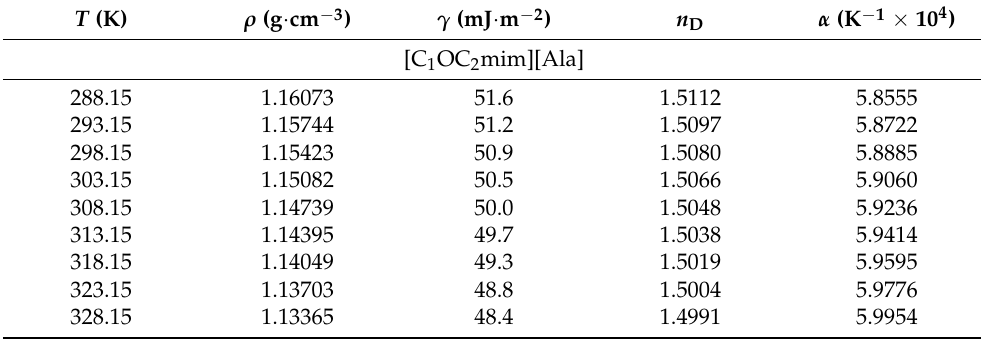
Figure 1. Density ( ρ ), surface tension ( γ ), and refractive index ( n D ) plotted against water content ( w 2 ) at various temperatures for [C 1 OC 2 mim][Ala] ( a , c , and e , respectively) and for [C 2 OC 2 mim][Ala] ( b , d , and f , respectively). 288.15 K; 293.15 K; 298.15 K; 303.15 K; 308.15 K; 313.15 K; 318.15 K; 323.15 K; 328.15 K. Table 1. Density ( ρ ), surface tension ( γ ), refractive index ( n D ), and thermal expansion coefficient ( α ) at various temperatures ( T ) for [C n OC 2 mim][Ala]( n = 1,2). T (K)